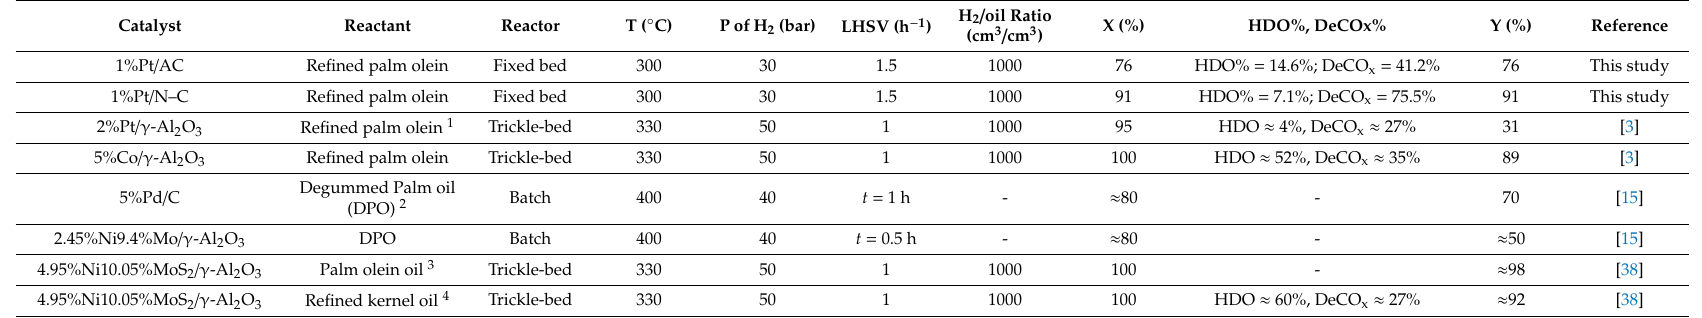
Table 2. Green diesel production from palm oil in di ff erent catalytic reaction